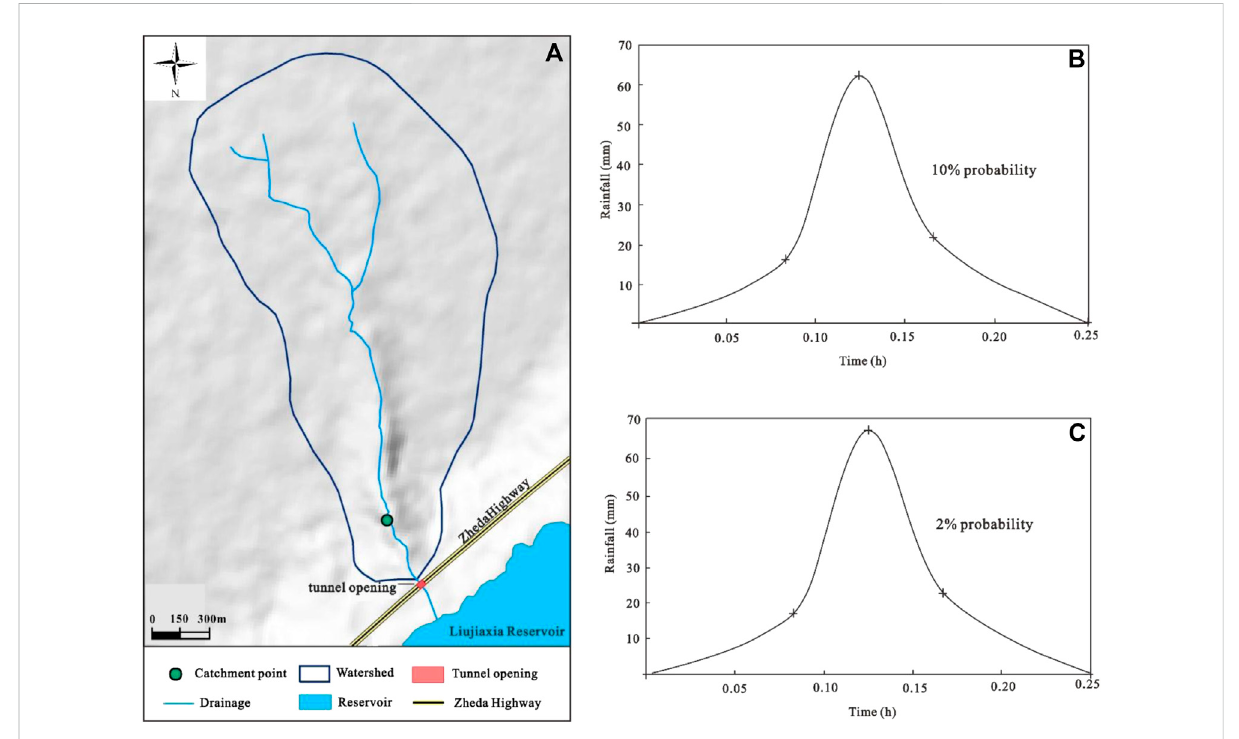
FIGURE 3 Catchment point setting and fl ow process curve of the analysed debris fl ow.